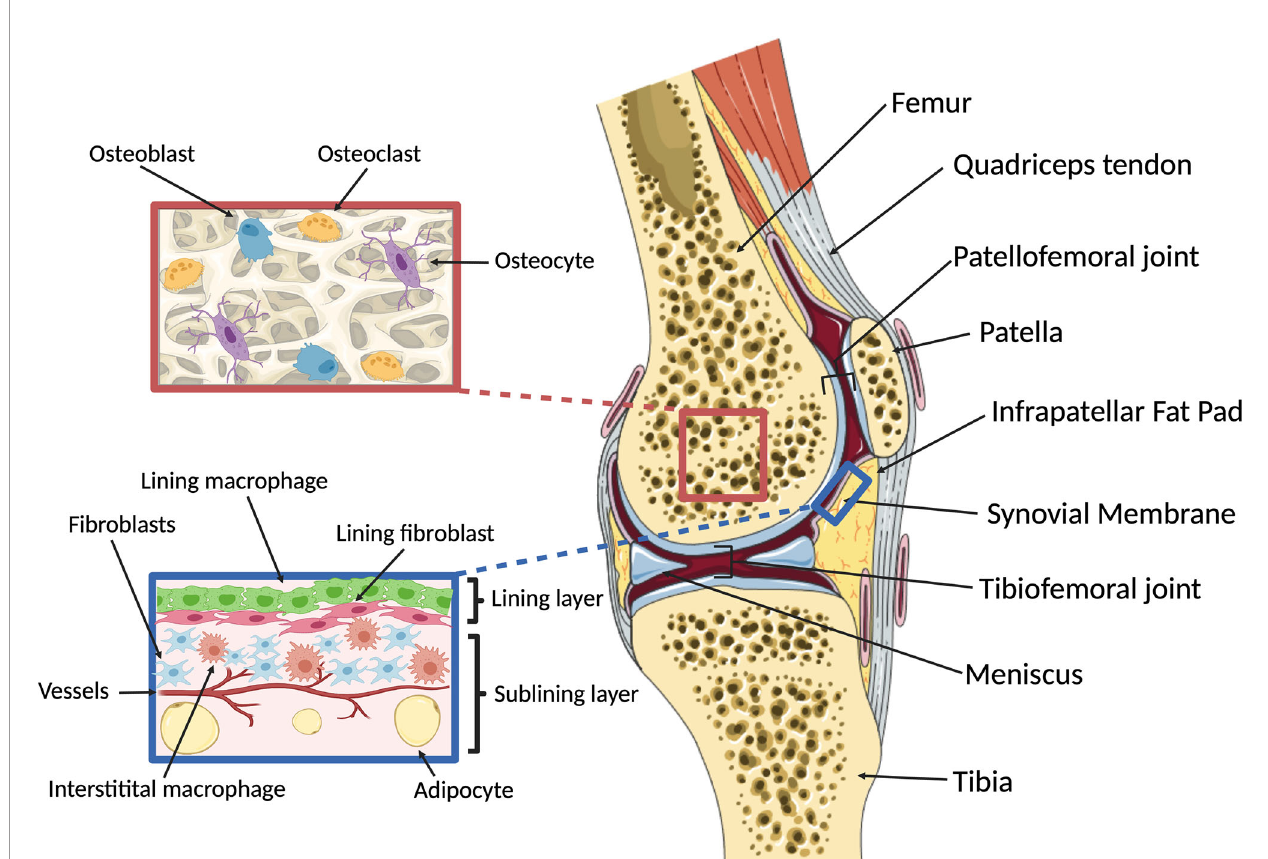
FIGURE 1 | Overview of knee macro- and microanatomy. (Right) Sagittal cut through a human knee. The femur and tibia articulate in the tibiofemoral joint, with two fi brocartilaginous menisci serving to provide rotational and anterior-posterior stability and load distribution. The patella is a hypomochlion (pivot point) for the quadriceps tendon that articulates with the femur in the patellofemoral joint. The intra-articular components of the osseous structures are covered by cartilage, enabling low-friction bearing. Joint function and stability are maintained by ligaments and the joint capsule. The inner surface of the joint capsule is lined with the synovial membrane, which is accompanied by adipose tissues located intra-articularly and extra-synovially, including the infrapatellar fat pad. (Left, top) Microanatomy of subchondral bone. The cellular components of bone include osteoblasts, osteoclasts and osteocytes that dynamically respond to changes in mechanical loading and potentially communicate with the overlying cartilage via soluble signals. (Left, bottom) Microanatomy of the synovial membrane. The synovium comprises three layers: the intimal lining layer which consists of macrophages and fi broblasts that together form a semi-permeable protective barrier; the vascularized subintimal or sublining layer which contains interstitial macrophages and fi broblasts as well as adipocytes; and an outer fi brous stromal layer forming the joint capsule (not shown). Created with BioRender.com and